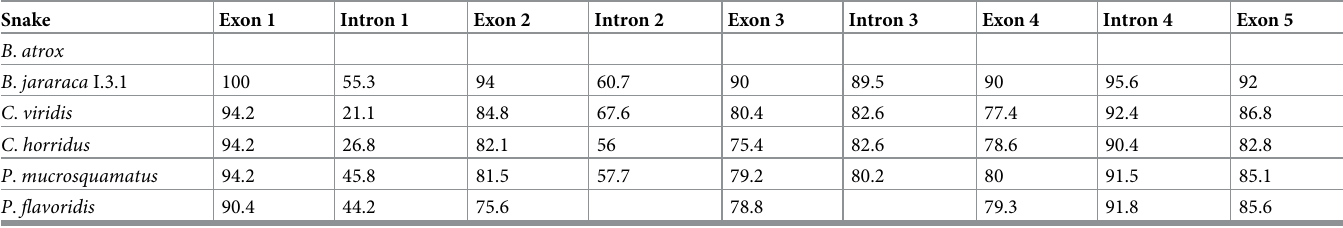
Table 3. The similarity of SVTLE genes in percent identity, related to the batroxobin gene.